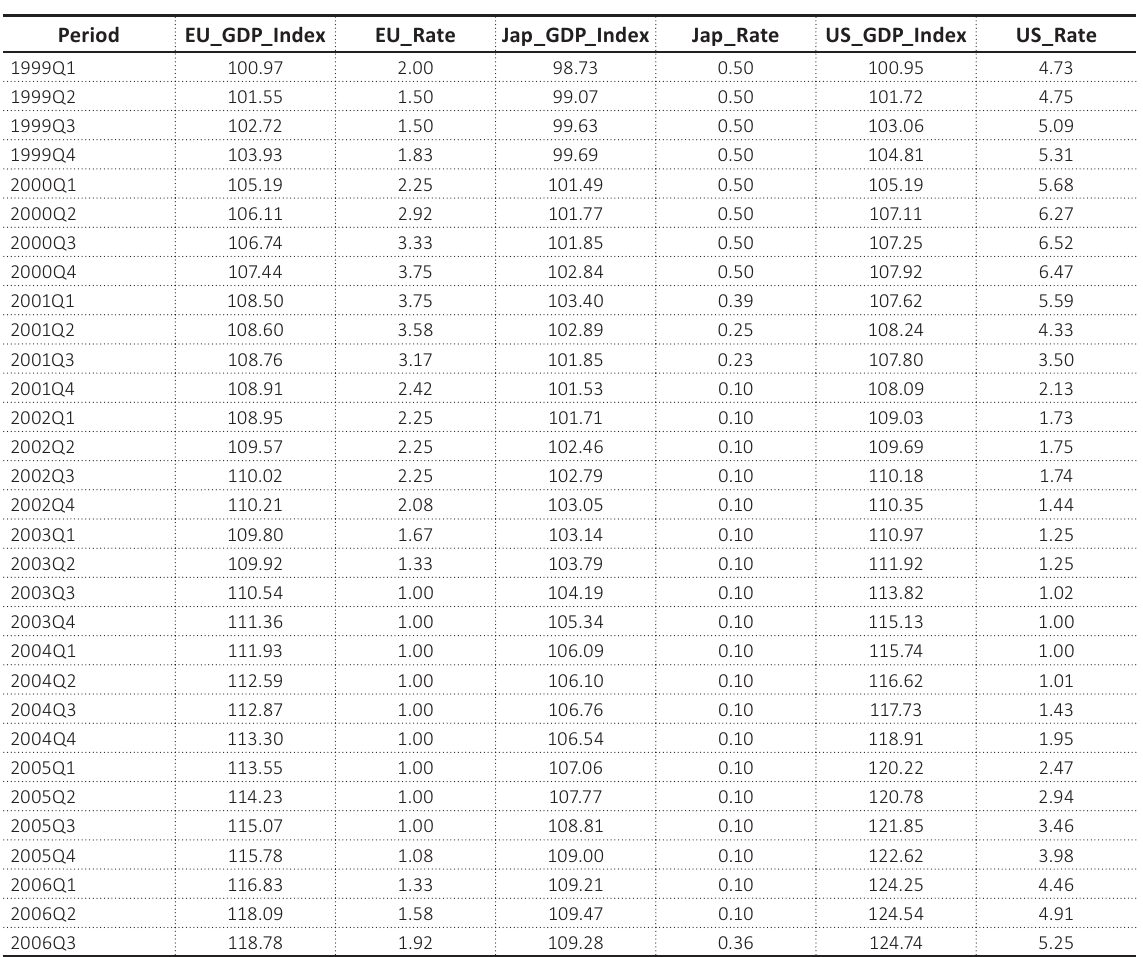
Table A2. Data set for the